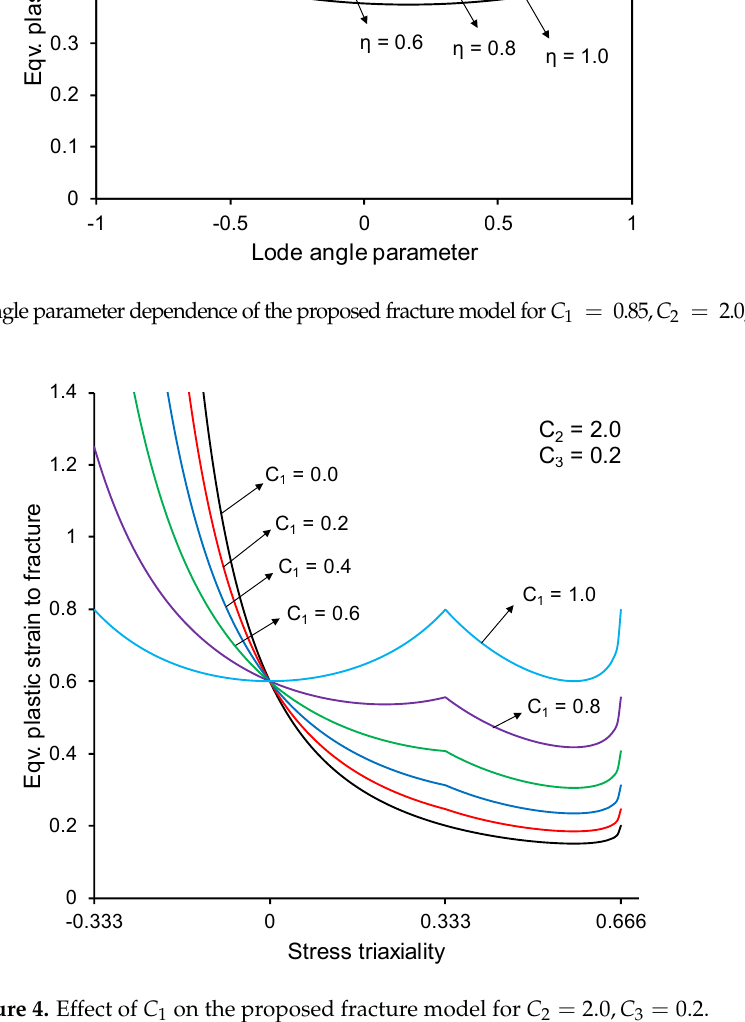
Figure 4. Effect of C 1 on the proposed fracture model for C 2 = 2.0, C 3 =